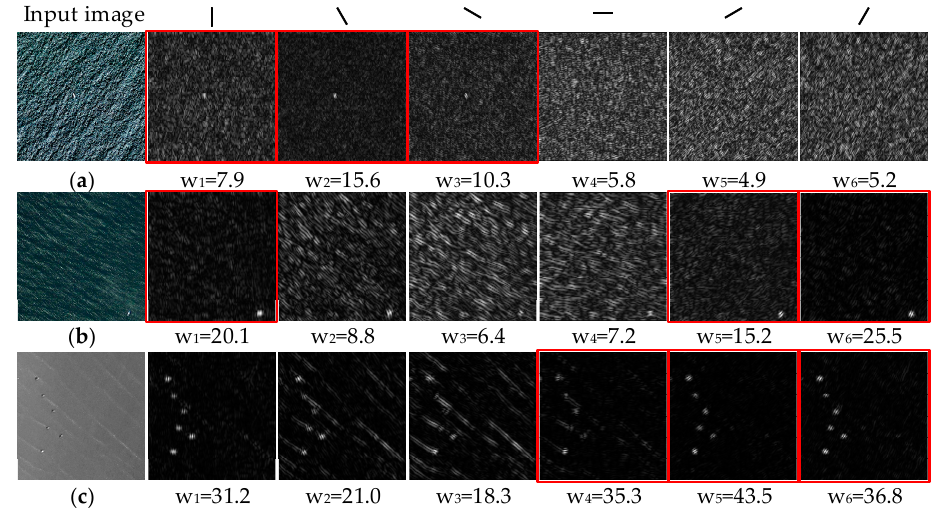
Figure 4. The generated saliency maps based on the 3-level Steerable Pyramid (SP) decomposition. The first column presents the test optical remote sensing (ORS) images with strong sea clutter. The remaining columns present their corresponding orientation saliency maps. Besides, w p ( p = 1,2,..,6) denotes the efficiency weight of the p -th orientation saliency map. A selection strategy is performed to suppress the strong sea clutter. The remaining saliency maps are marked with red boxes.